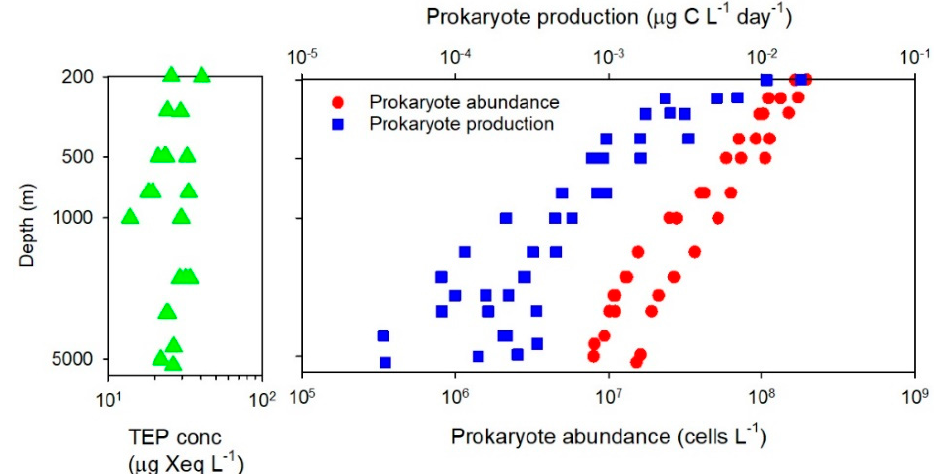
Figure 1. Vertical distributions of TEP concentrations, prokaryote abundance, and prokaryote production in the central Pacific Ocean. The graphs were made using the original data of Yamada et al. [19]. Both x and y axes are logarithmic.